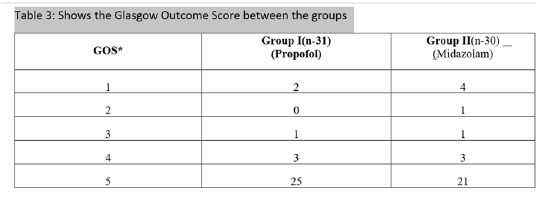
Table 3 Shows the Glasgow Outcome Score between the